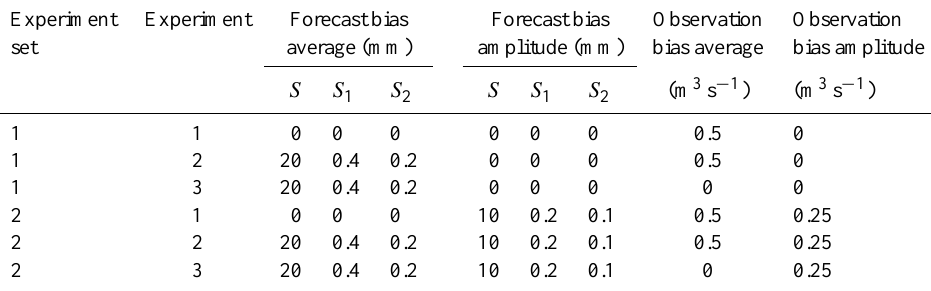
Table 1. Properties of the observation and forecast bias in the synthetic experiments. Experiment Experiment Forecast bias Forecast bias Observation Observation set average (mm) amplitude (mm)